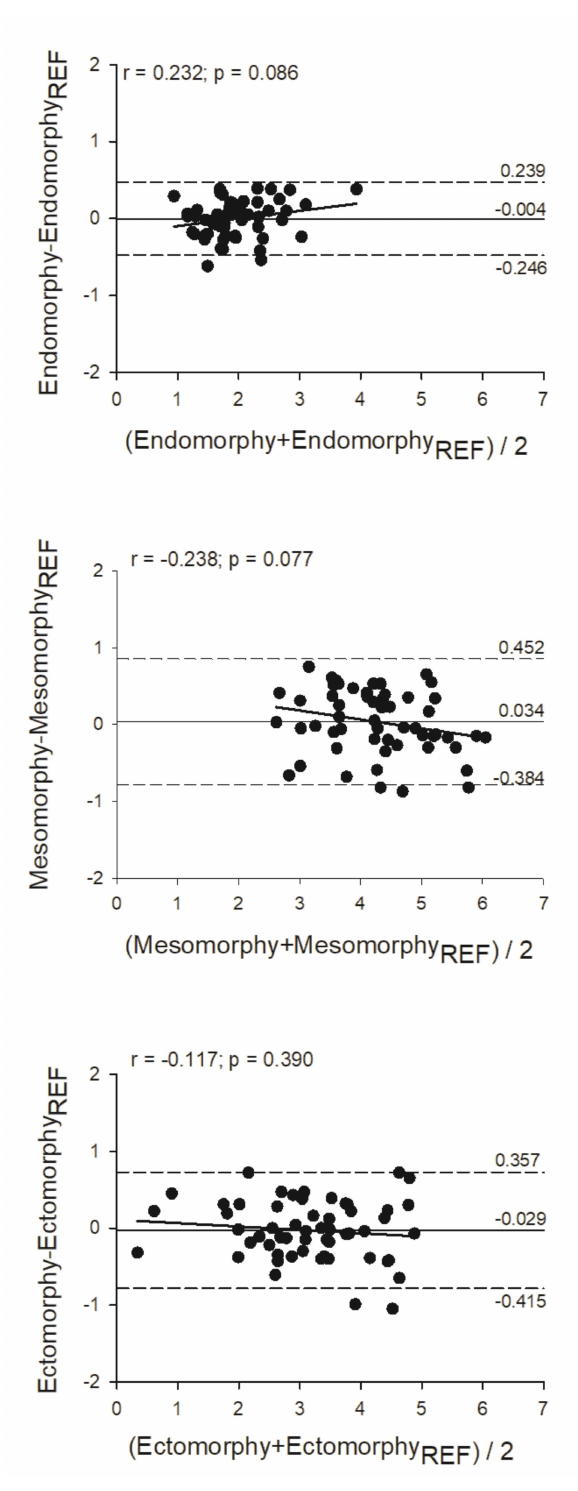
Figure 2. Bland-Altman analysis of the agreement between methods for the somatotype’s components estimation. The middle solid line represents the mean di ff erences between the values obtained by the new equations and the reference method (Ref) and was predicted by the equations. The upper and lower dashed line represents the 95% limits of agreement ( ± 1.96 SD). The trend line represents the degree of association between the di ff erences of the methods and the mean of both methods, as illustrated by the coe ffi cient of correlation